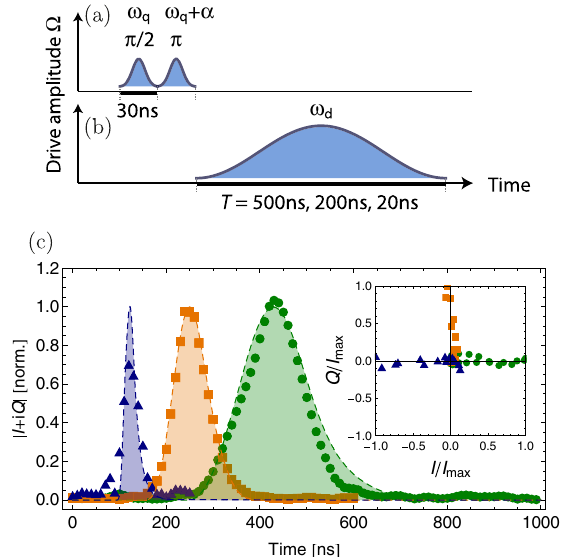
FIG. 2. (a) Amplitude of the drive signal used to initialize the transmon and (b) transfer the excitation into the resonator to generate a symmetric photon shape. (c) The normalized voltage amplitude j I þ iQ j of shaped photons obtained for drive pulses with T ¼ 20 ns, Ω 0 = 2 π ¼ 680 MHz(bluetriangles), T ¼ 200 ns, Ω 2 π ¼ 700 MHz (orange squares), and T ¼ 500 ns, Ω 0 = 600 MHz (green circles). The dashed lines show the simulated photon shapes scaled to normalize their peak values to unity. The measured traces are fitted to the simulation with only the time shifts and scaling factors as fit parameters. The inset shows both voltage quadratures I and Q of the photon